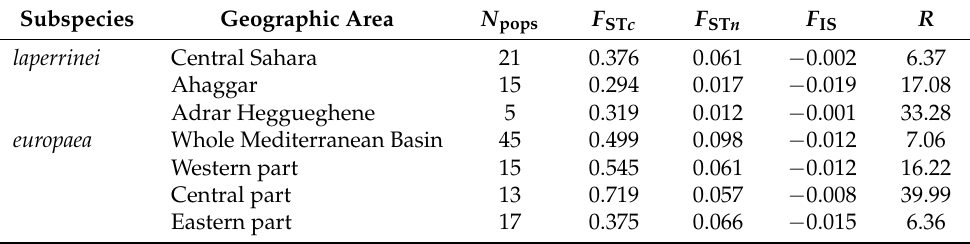
Table 3. Parameter values used in the Ennos’s equation [26] in different geographic areas in order to estimate the pollen to seed ratio ( R ) in populations of two olive subspecies ( laperrinei and europaea ): N pops represents the number of subpopulations, F ST c and F ST n represent the differentiation value based respectively on plastid and nuclear polymorphisms, F IS represents the level of inbreeding. Three geographic scales were considered for the Laperrine’s olive (i.e., Central Sahara, Ahaggar, Adrar Heggueghene), whereas three main regions were delimited in the Mediterranean Basin (data from